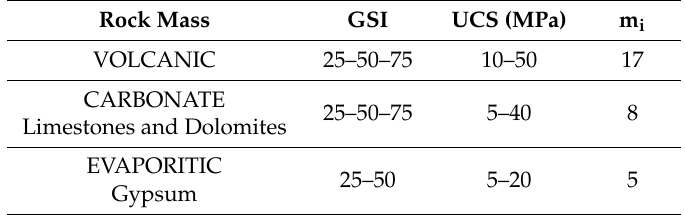
Table 2. Geomechanical parameters used according to the type of rock